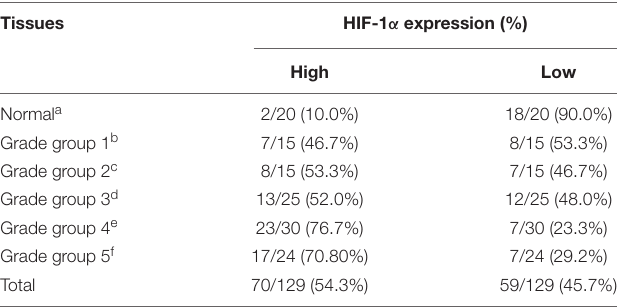
TABLE 3 | Expression of HIF-1 α in normal prostate tissues and different grade groups of prostate cancer tissues. Tissues